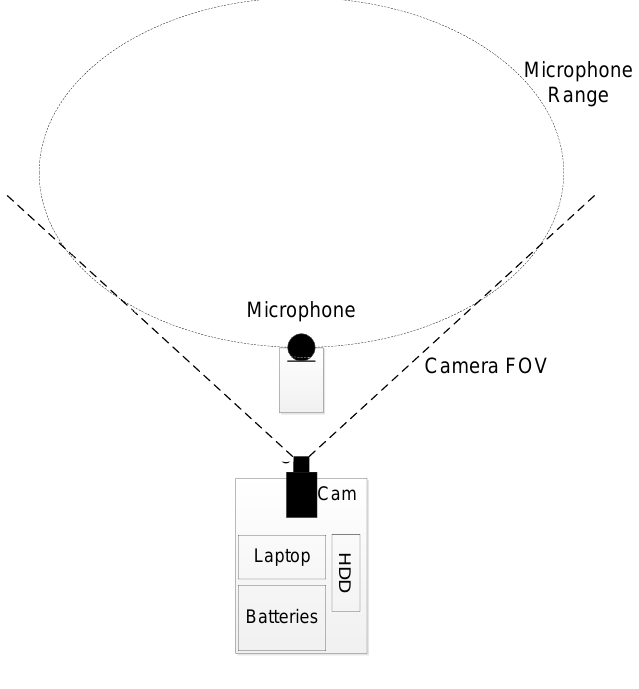
Figure 2. Sketch of the equipment used for data collection. The camera captures a video stream for later inspection of behaviour. Both audio and video data are stored on an external hard drive. The dashed lines indicate microphone range and camera field of